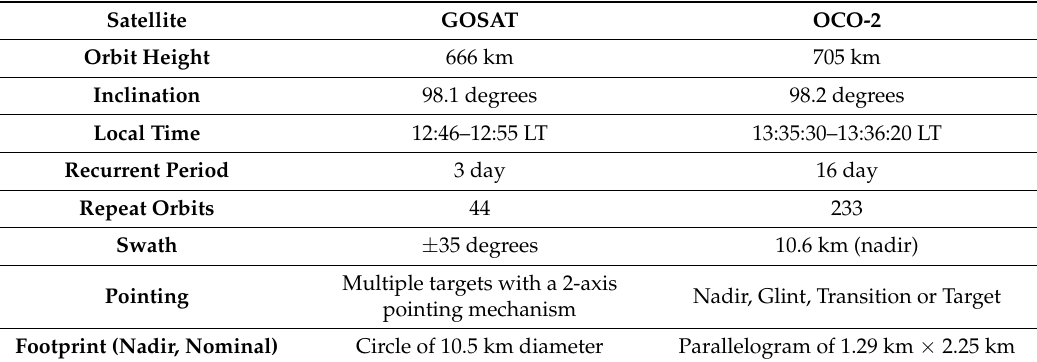
Table 2. Orbit and observation geometry of GOSAT and